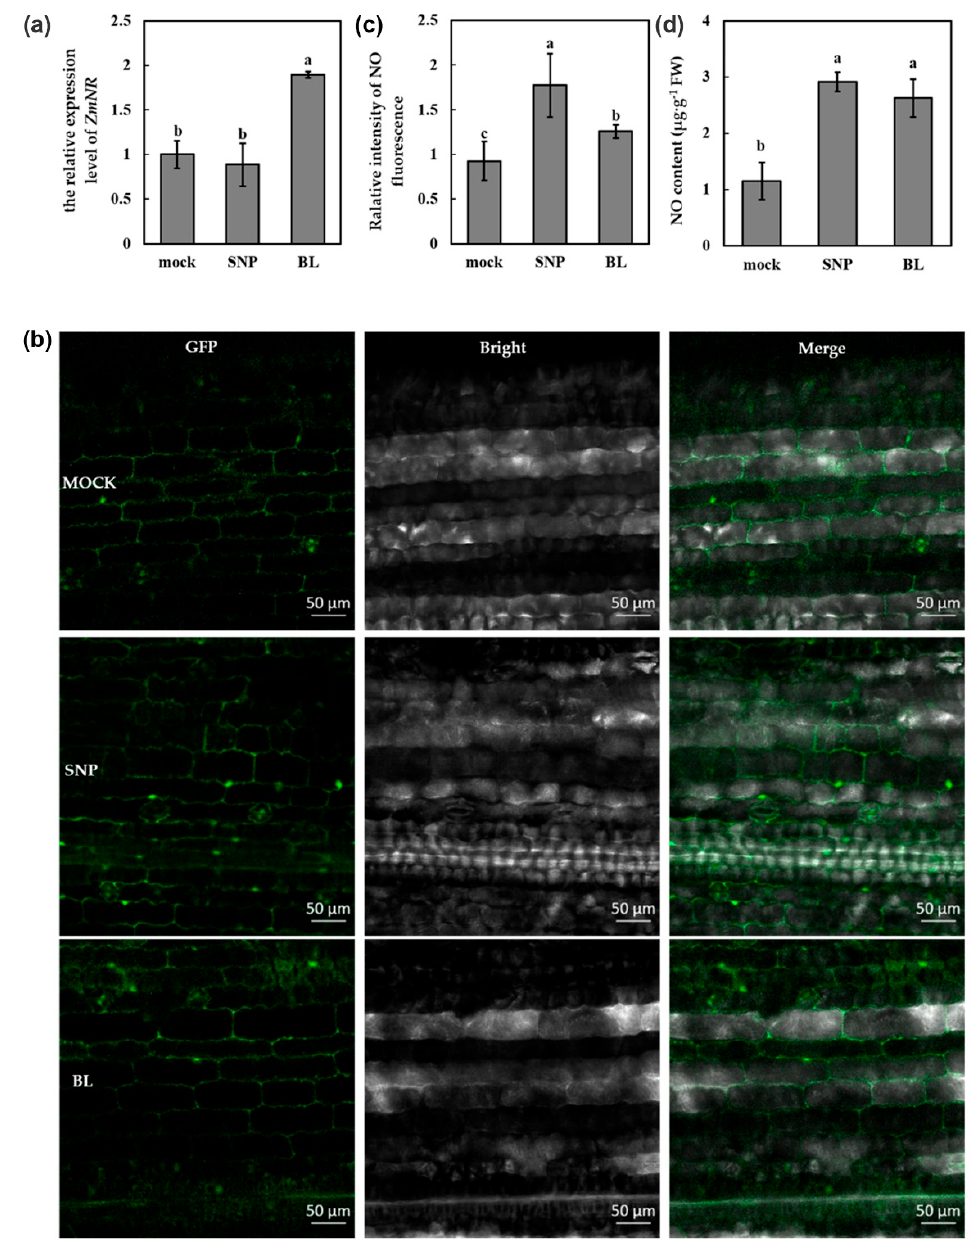
Figure 4. BR induced nitric oxide (NO) accumulation in maize. ( a ) RT-qPCR analysis of the transcript levels of NO synthetic gene ZmNR . ( b ) Image of NO level in leaves was detected by fluorescence resulting from DAF-FM-DA. Images were taken after 12 h of BL treatment using a fluorescence microscope. Scale bars = 50 µ m. ( c ) Intensity of fluorescence of various treatments was analyzed with Image J software. ( d ) Quantitative measurements of NO content in the leaves. mock: leaves pretreated with Tween-20 (0.02%); SNP / BL: leaves pretreated with SNP, or BL. Data are means ± SD from three biological replicates. Statistical analysis was performed using SPSS 16.0 followed by ANOVA with LSD test at the level of p -value ≤ 0.05. Significant difference between different samples was indicated in lowercase letters.